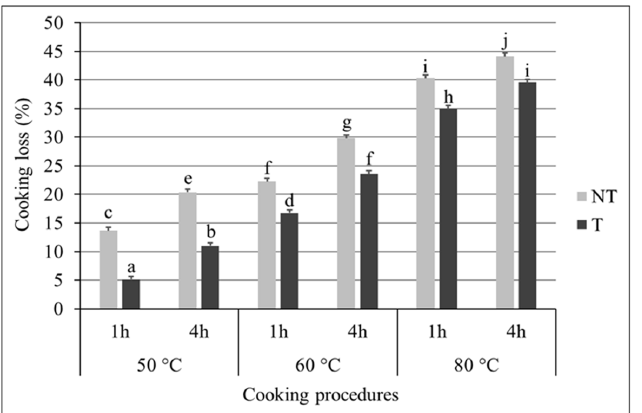
Figure 4. Cooking losses (CL) measured on bovine Semitendinosus muscle samples previously tumbled (T) or not (NT, used as control) and then sous-vide cooked at 50 °C, 60 °C or 80 °C for 1 h or 4 h. The data correspond to mean values ± standard error (SE) calculated from nine 3 cm thick slices prepared from three different ST muscles. Different letters (a–j) refer to significant differences between all treatments.